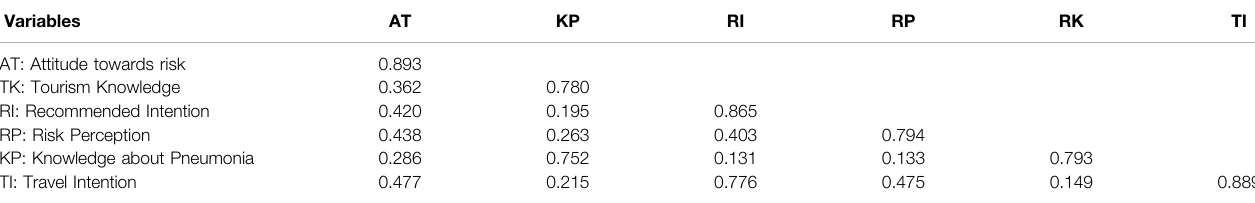
TABLE 3 | Fornell-larcker criterion. Variables AT TI AT: Attitude towards risk